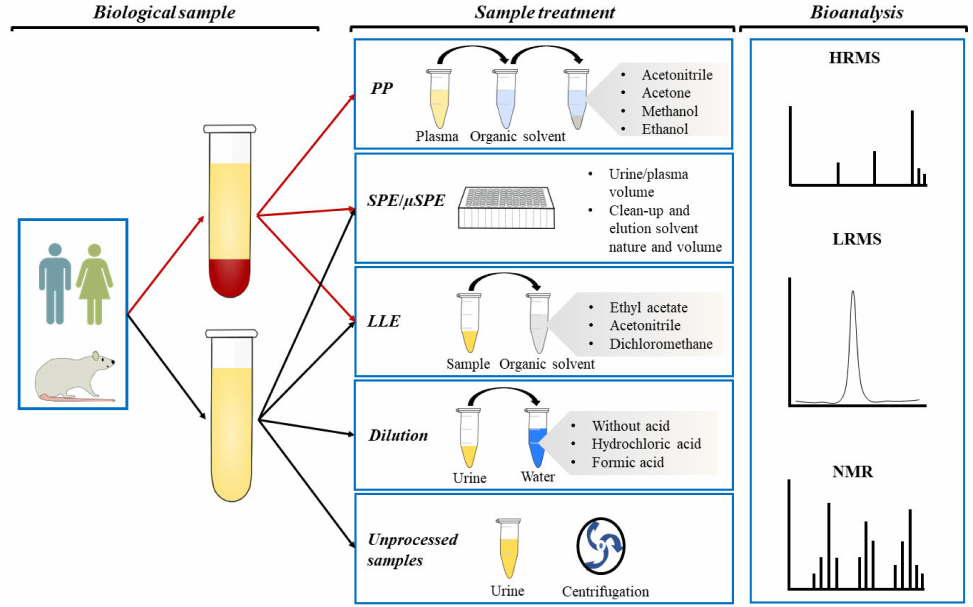
Figure 1. Graphical representation of plasma and urine clean-up and the bioanalysis for the identifi- cation and quantification of phenolic